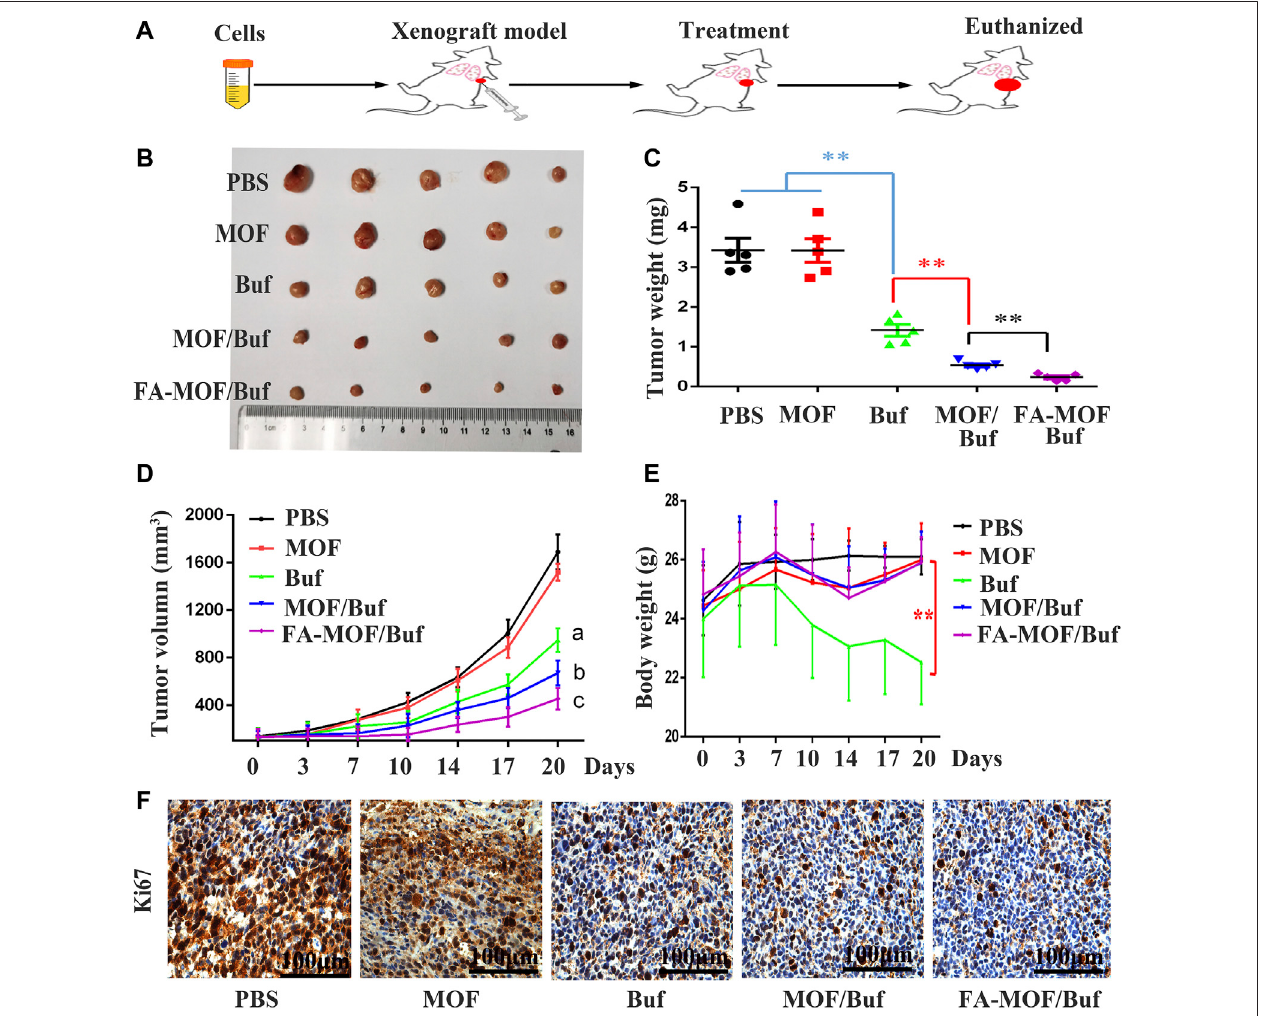
FIGURE5| Anticanceref fi cacyonthesubcutaneoustumormousemodel. (A) Flowchartoftheexperiment. (B) Representativetumortissuesexcisedfrommiceat the end of treatment. (C) Tumor weight at the end of treatment. (D) Body weight of tumor-bearing mice during the period of treatment. (E) Tumor volume with time after cancercellinoculation. (F) ExpressionofKi67incancertissues,measuredbyIHCstaining(scalebar:100 μ m).Dataareexpressedasmean ± SD( n (cid:1) 6),** p < 0.01, a p < 0.01 Buf vs. PBS, b p < 0.05 MOF/Buf vs. Buf, c p < 0.05 FA-MOF/Buf vs.